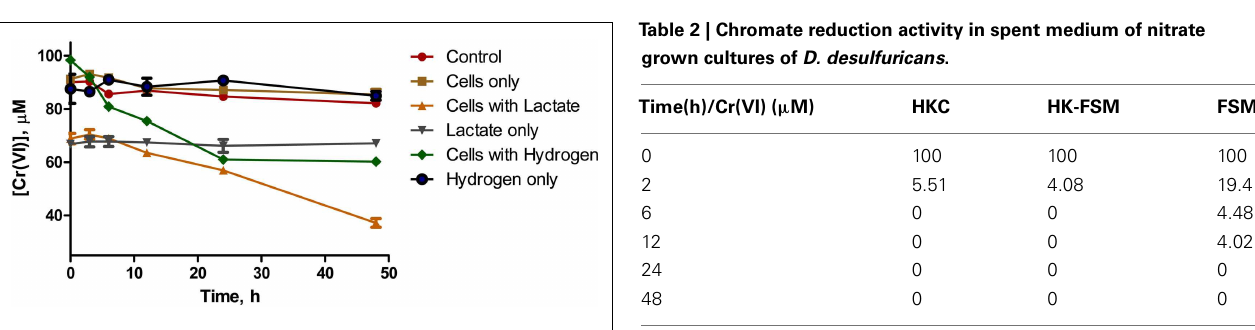
FIGURE 5 | Chromate reduction in whole cells of D. desulfuricans provided with lactate ( (cid:78) ) or hydrogen ( (cid:7) ) as electron donor. Controls ◦ were Cr(VI) with no cells or donor ( ), Cr(VI) with cells only ( (cid:4) ), Cr(VI) with • lactate only and no cells ( (cid:79) ), Cr(VI) with hydrogen only and no cells ( ). Table 3 | Chromate reduction activity in spent medium of nitrate grown cultures of S. barnesii